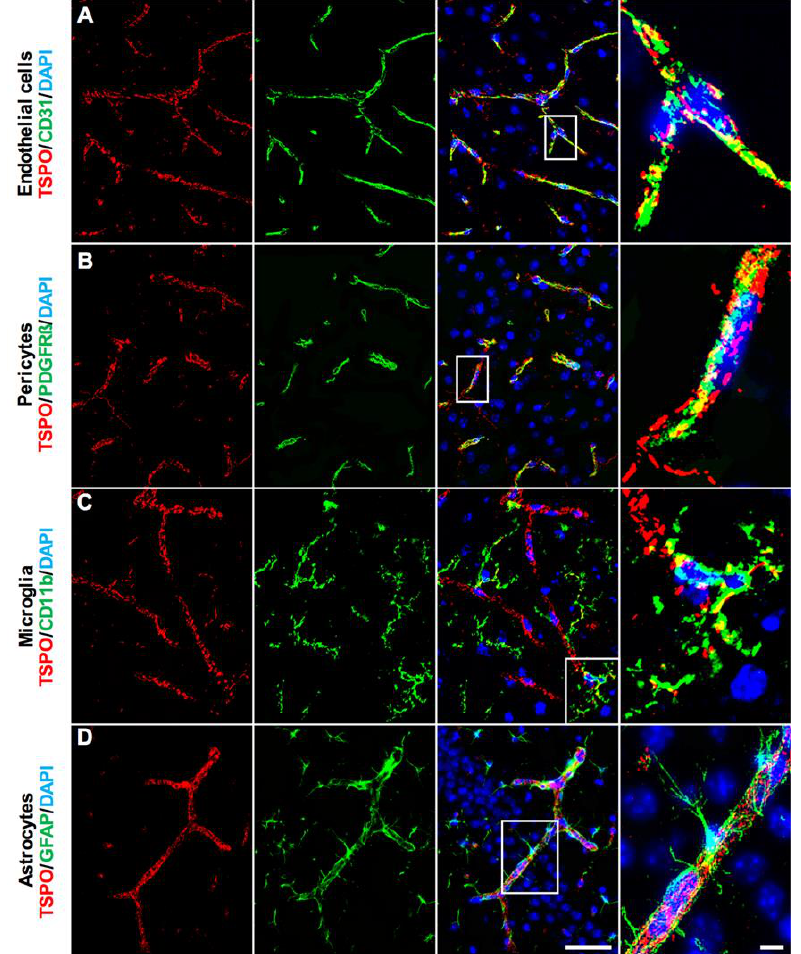
Figure 2. TSPO expression in major cell types of the normal mouse brain. ( A ) Double immunofluorescence staining for TSPO (red) demonstrates punctate staining which colocalizes strongly with CD31+ vascular endothelial cells (green). This is observed in larger blood vessels, smaller arterioles and venules, as well as capillaries. Punctate staining is indicative of mitochondrial localization. ( B ) TSPO expression (red) and PDGFRβ+ pericytes/smooth muscle cells (green) colocalize on larger blood vessel walls. ( C ) No clearly discernible TSPO expression (red) is observed in CD11b+ microglia (green). ( D ) TSPO expression (red) is not observed in GFAP+ astrocytes (green). Perivascular astrocytic endfeet and processes surround CD31+ endothelial cells of blood vessels, where TSPO strictly colocalizes. Scale bars = 20 µm, 10 µm for box insets.